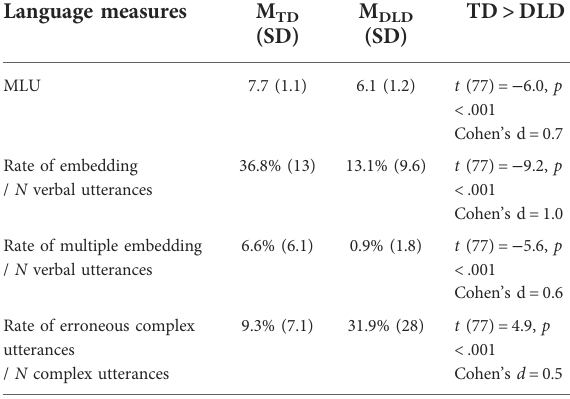
TABLE 4 TD versus DLD: measures of complex syntax. Language measures